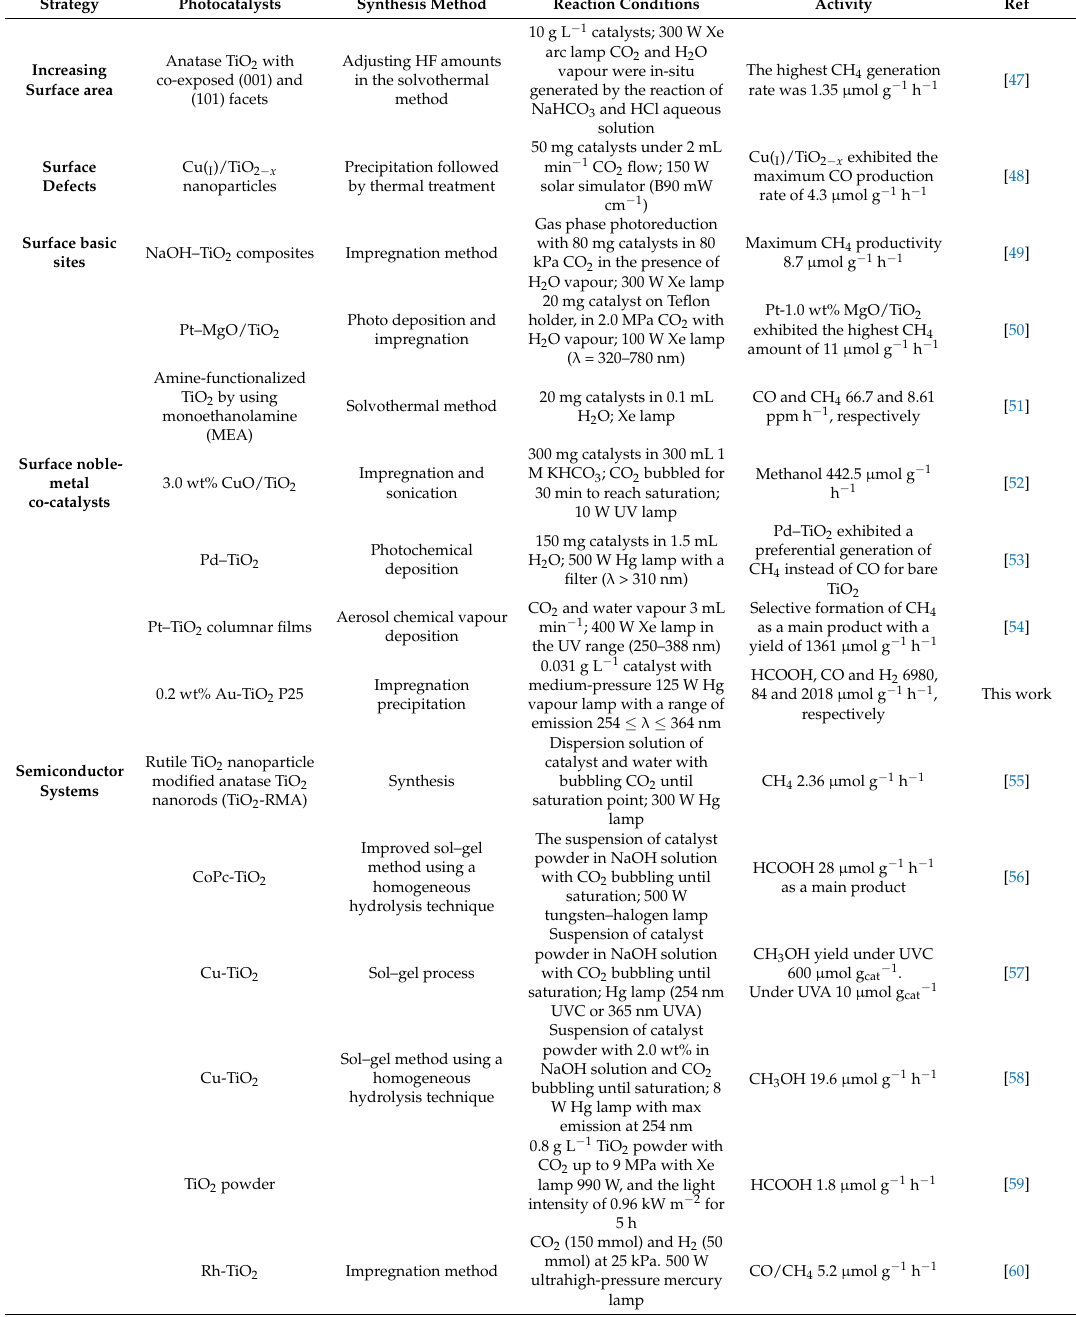
Table 3. Comparison of the photocatalytic performance for CO 2 photoreduction of TiO 2 -based photocatalysts obtained with different